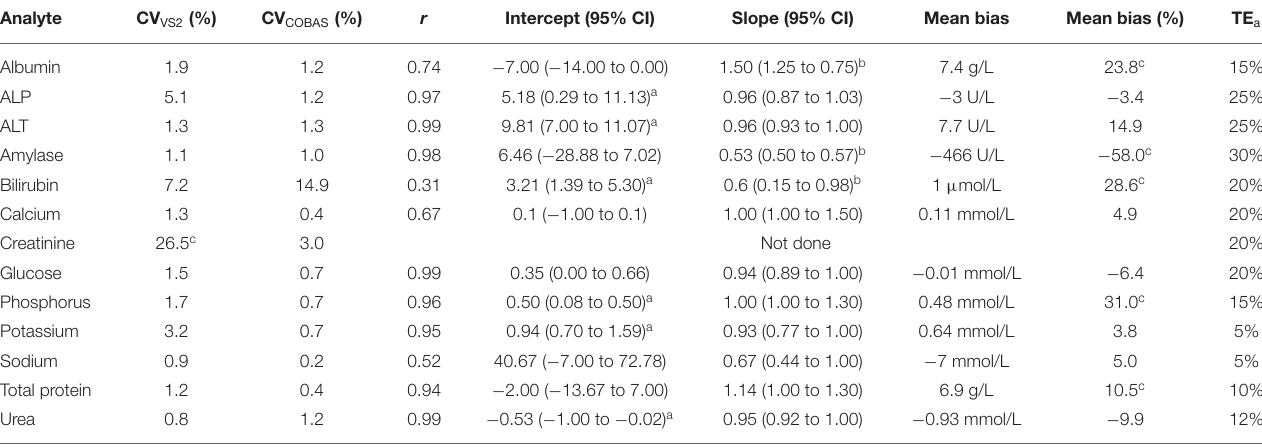
TABLE 2 | Short-term imprecision (CV), Spearman’s correlation coefficient ( r ), Passing-Bablok regression data (intercept and slope), and mean bias of the Abaxis Vetscan VS2 compared to the Roche Cobas Integra 400 Plus for Temminck’s pangolin heparin plasma. Analyte